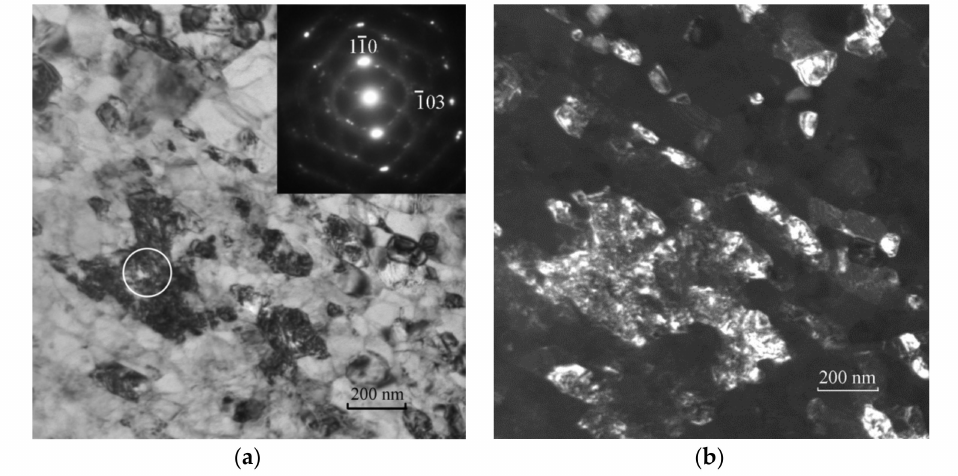
Figure 1. Bright-field image of mixed grain–subgrain structure with a submicron subgrain region, corresponding SAED pattern from the circled region, zone axis [331] ( a ), and dark-field image ( b ) in B2-austenite reflection